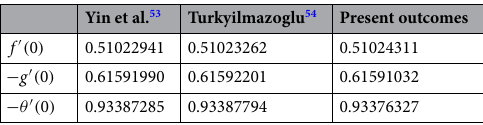
Table 4. Comparative studies of